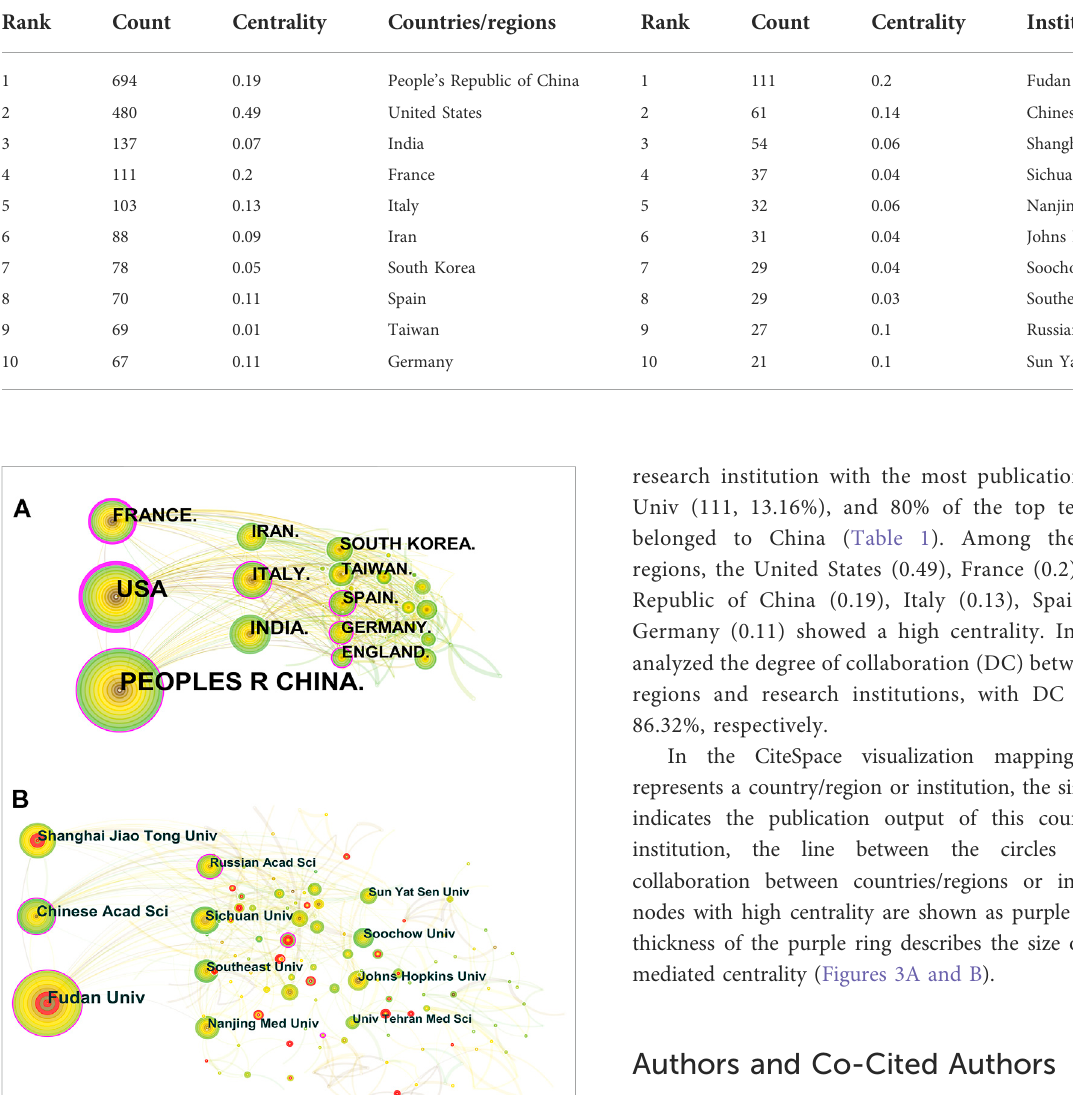
FIGURE 3 (A) Distribution of publications on nanotechnology in glioma research from different countries/regions. (B) Distribution of publications on nanotechnology in glioma research from different